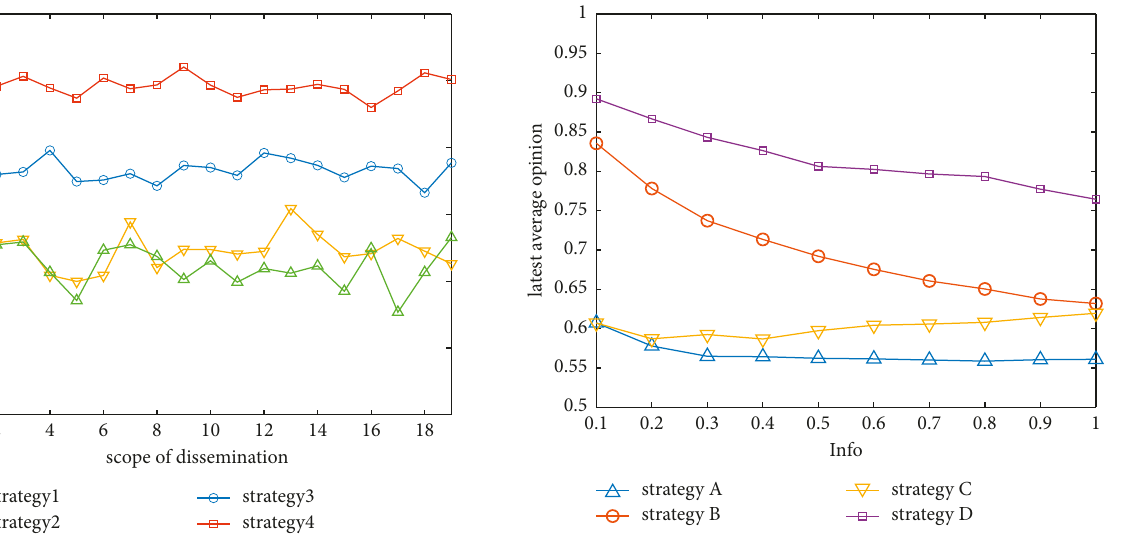
Figure 8: The distribution of the result of average opinion by the guidance from key agents. The scope of transmission represents that the scope of key agents can spread its opinion once time.